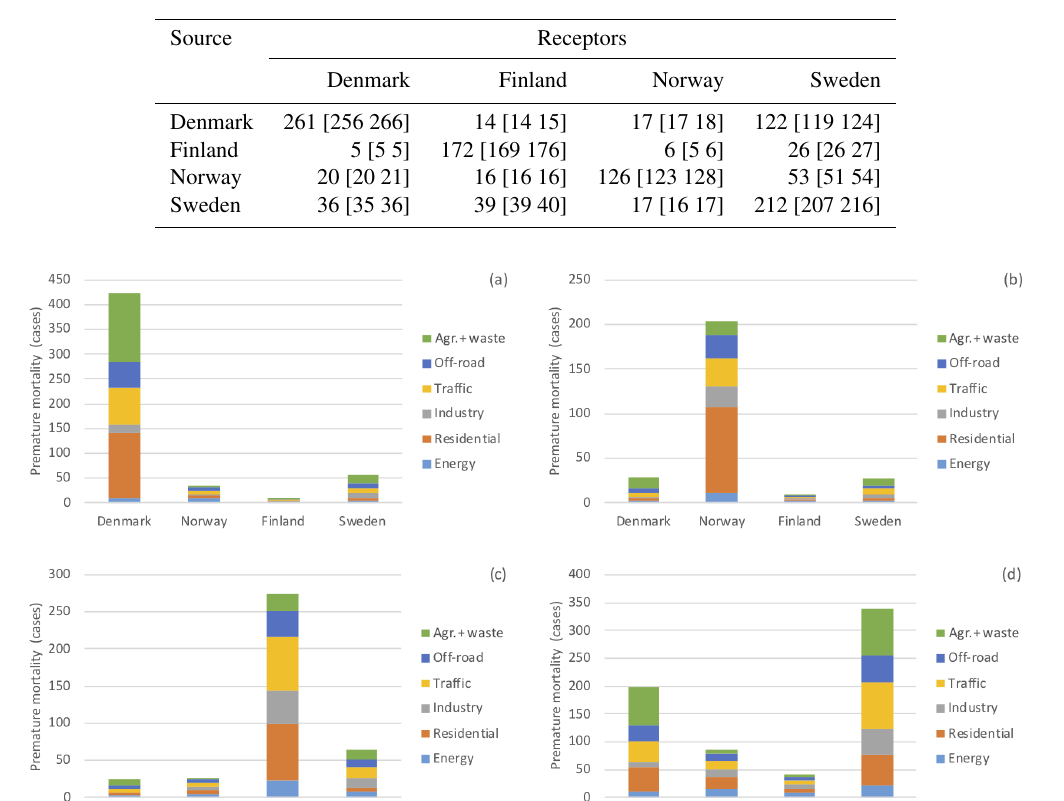
Table 7. Contribution of costs (EURmillion) of air pollution impacts on human health in the Nordic countries. The brackets show the 95% confidence interval.